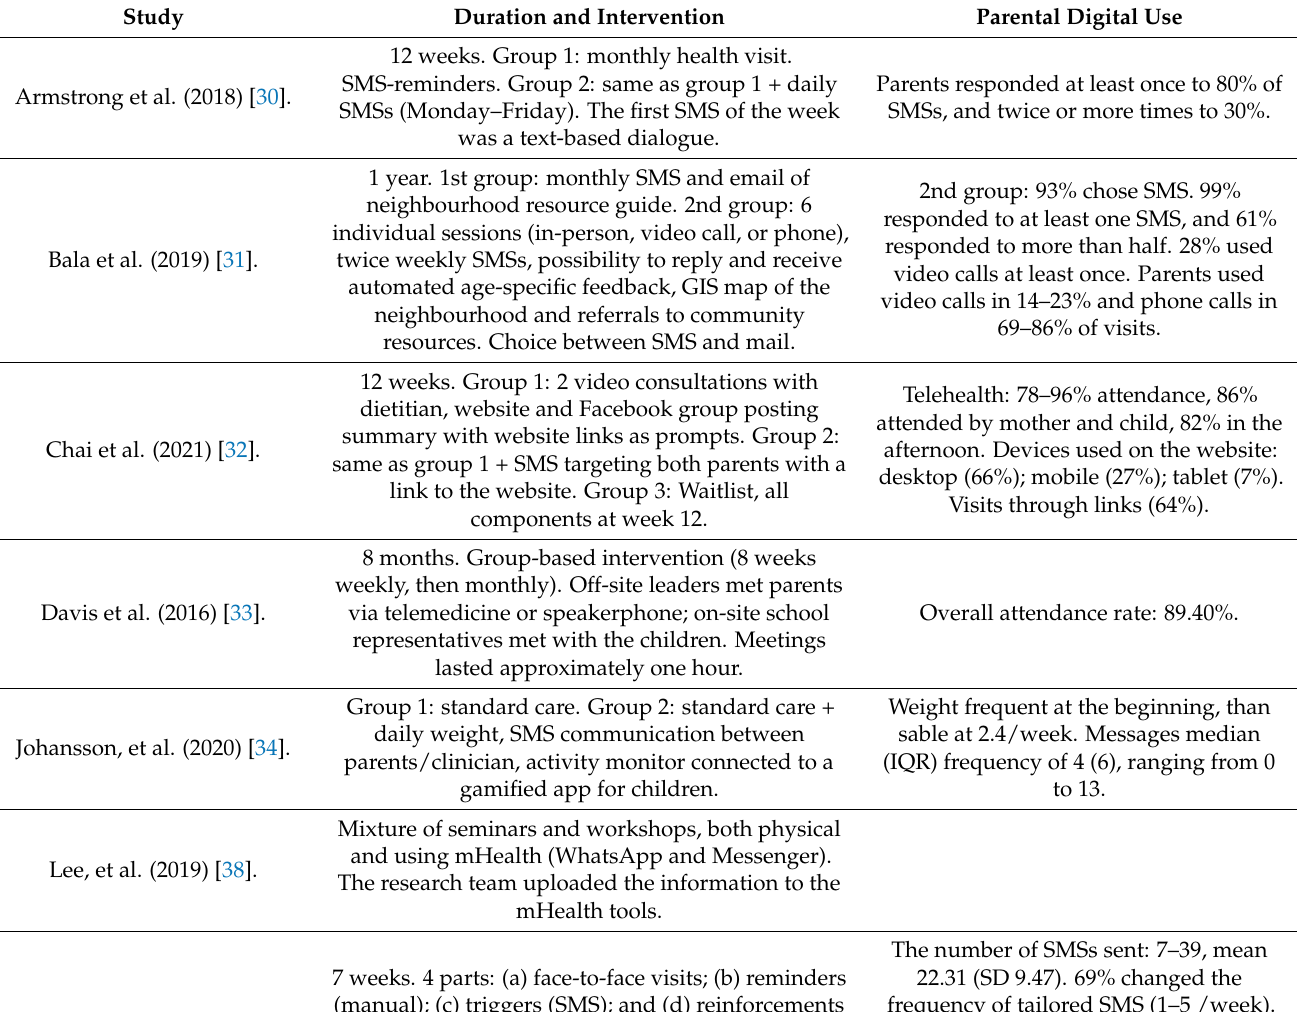
Table 2. Included studies part 2, Intervention and